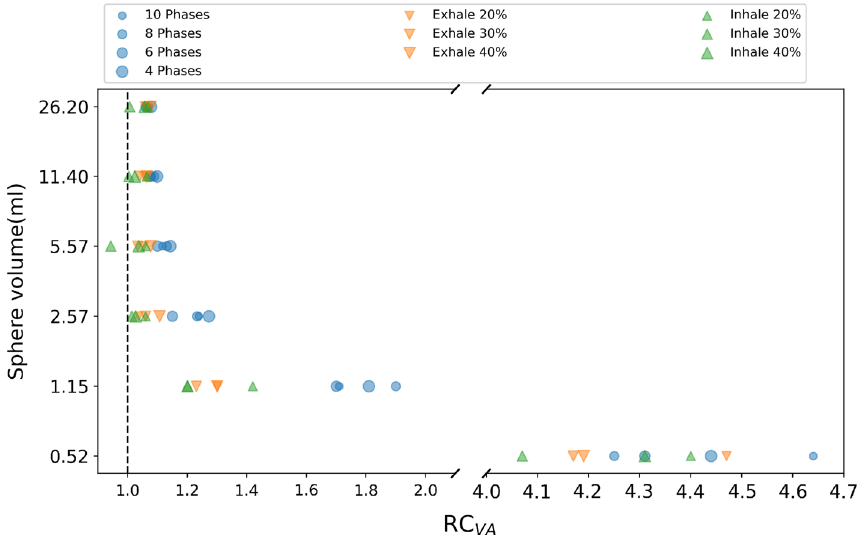
Fig. 7 Average of the volume RC for the three movements per protocol for each NEMA sphere. RC is 1 for ideal